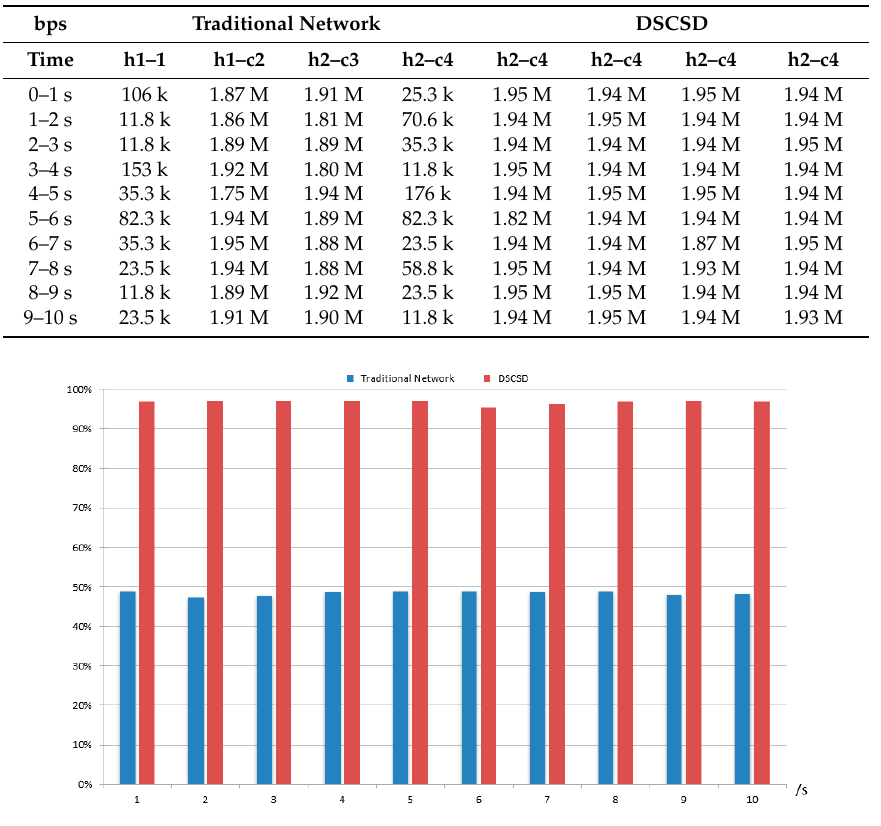
Figure 5. Overall link utilization comparison.